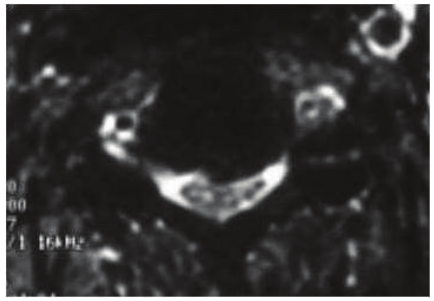
Figure 3: Axial T2 cervical spine denoting spondylotic changes and cord